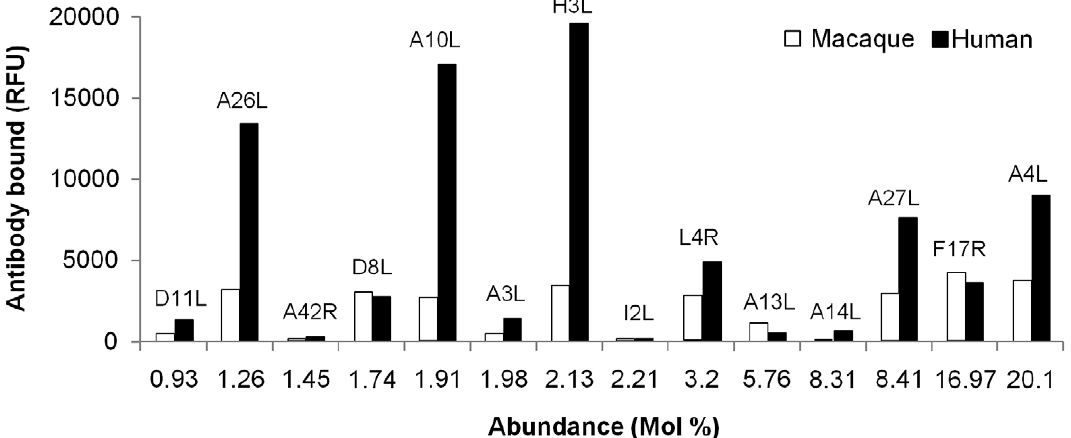
Figure 3. Relationship between antibody responses and abundance of IMV proteins. Relative levels of antibody binding were plotted against the most abundant proteins of vaccinia IMV [refs 17–20], using convalescent macaque and vaccinated human sera.